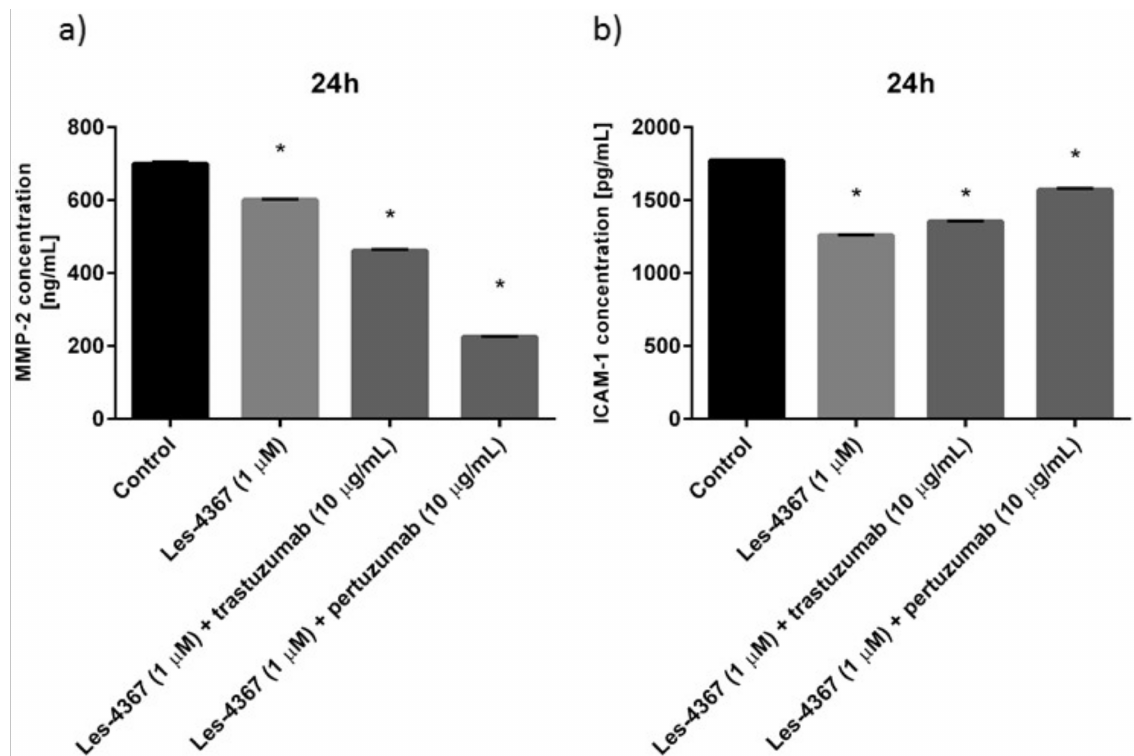
Figure 10. Concentrations of MMP-2 ( a ) and ICAM-1 ( b ) in AGS cells after 24 h incubation with Les-4367 (1 µ M) and combined with anti-HER2 antibodies. The ANOVA and Tukey tests were used to demonstrate differences between the control cells and the cells exposed to varying concentrations of the tested compounds. * p ≤ 0.05 vs. control